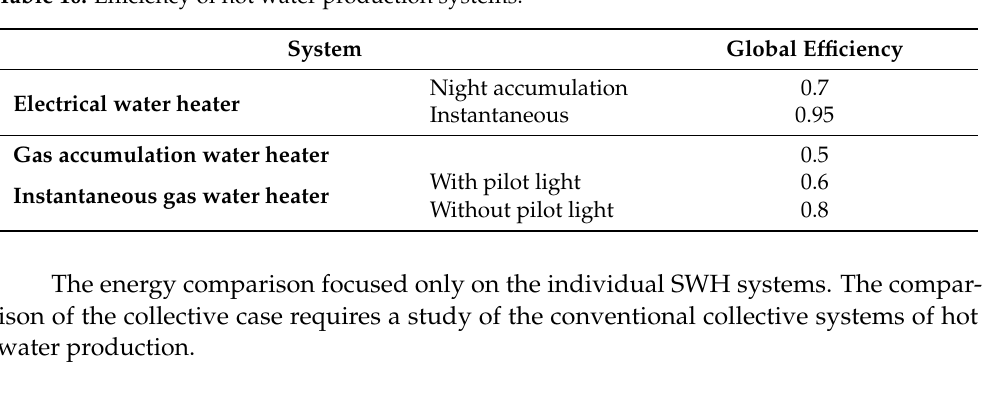
Table 10. Efficiency of hot water production